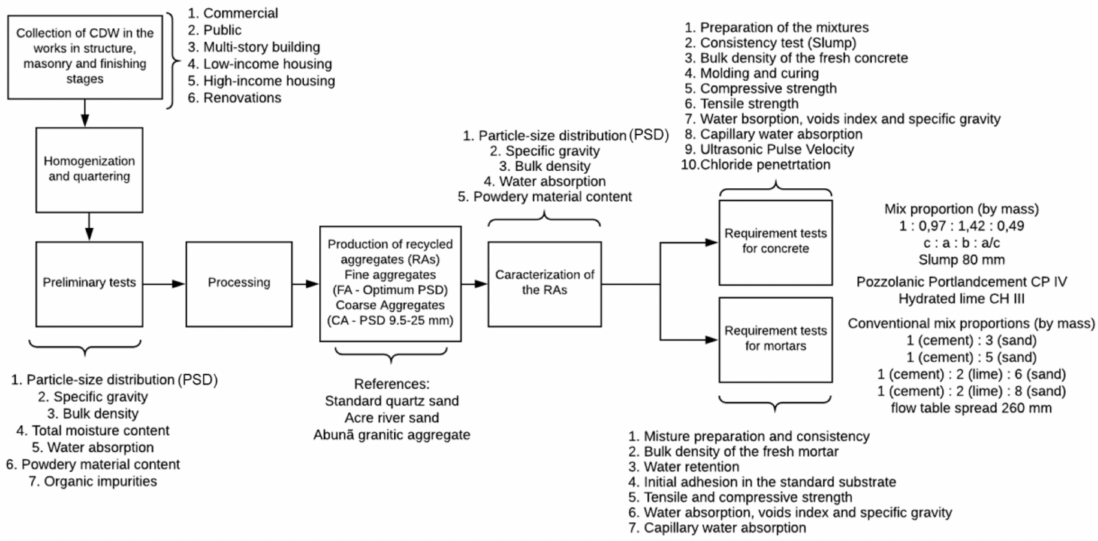
Figure 1. Flowchart of the adopted